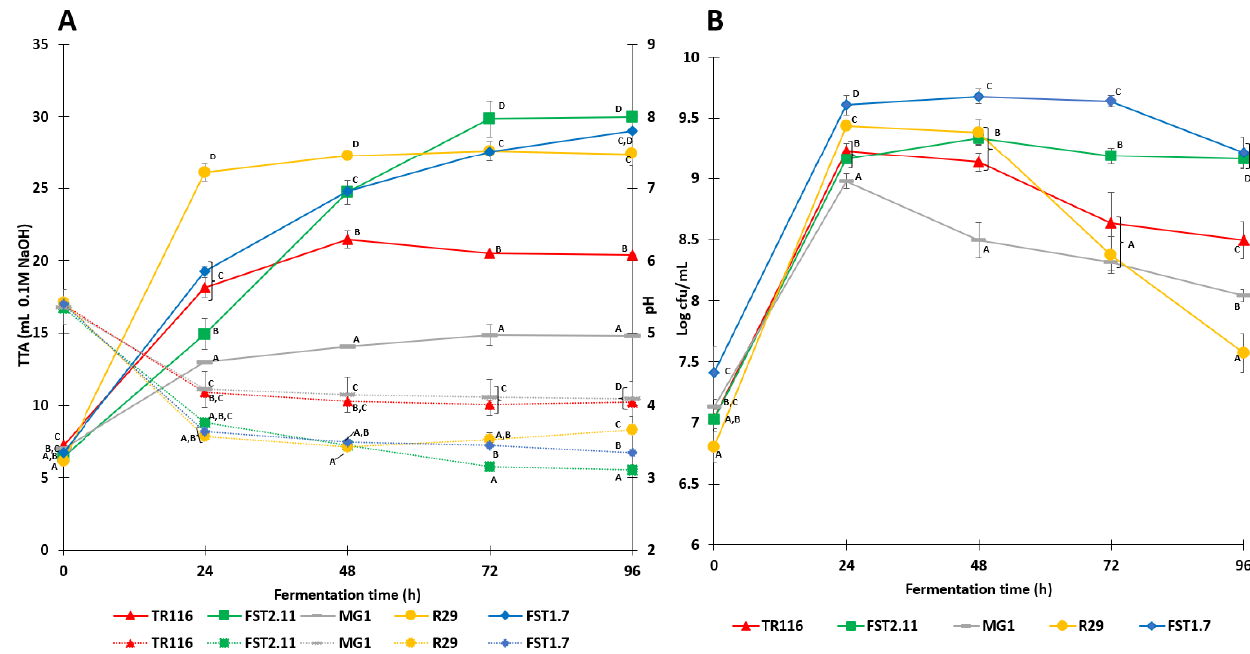
Figure 1. Acidification and microbial growth of Leuconostoc citreum TR116 (TR116) ( ), Lactobacil- lus amylovorus FST2.11 (FST2.11) ( ) , Weissella cibaria MG1 (MG1) ( ) , Limosilactobacillus reuteri R29 (R29) ( ) and Lactiplantibacillus plantarum FST1.7 (FST1.7) ( ) . ( A ) Development of total titratable acids (TTA) (solid line) and pH (dotted line); ( B ) cell count (CFU/mL) during fermentation. Points which share the same letter do not differ significantly.